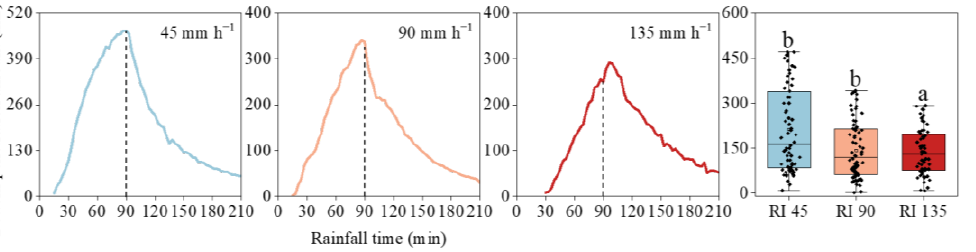
Figure 5. The bottom penetration generation processes under different rainfall intensities. Error bars represent standard errors of the means ( n = 80). Bars with different letters differ significantly.